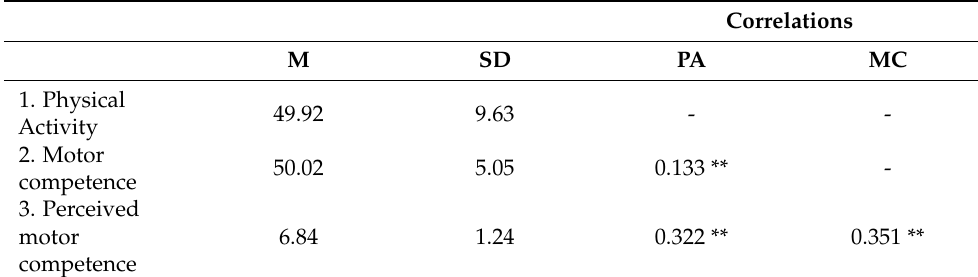
Table 2. Descriptive and correlational analyses between physical activity, motor competence and perceived motor competence.